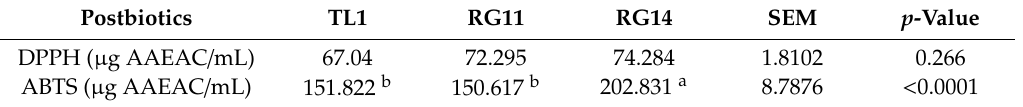
Table 3. 2,2-diphenyl-1-picryl-hydrazyl (DPPH) and 2,2 (cid:48) -azino-bis